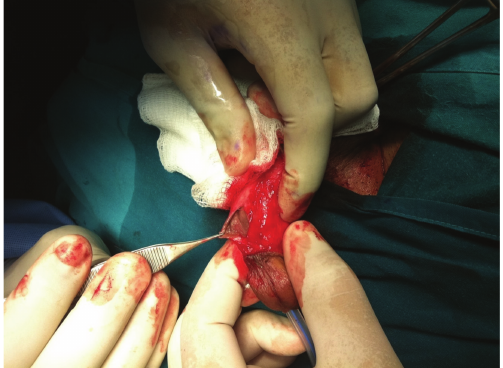
Figure 2: Inside of the cyst showing normal penile skin.